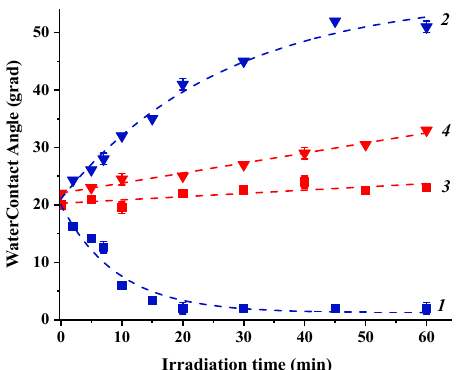
Figure 3. Kinetics of alteration of the water contact angle on the surfaces of TiO 2 (1 and 3) and TiO 2 /Cu 2 O (2 and 4) coatings under UV (1 and 2) and visible (3 and 4) light irradiation.